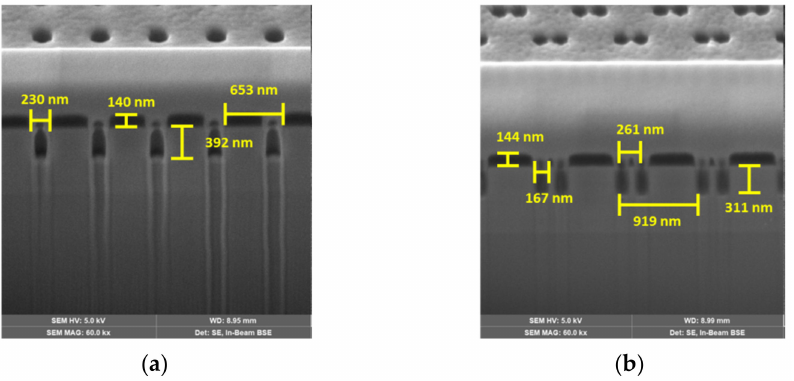
Figure 3. The cross-sectional SEM images of ( a ) single-hole PC structure (Device A) and ( b ) double- hole PC structure with shift distance of 160 nm (Device